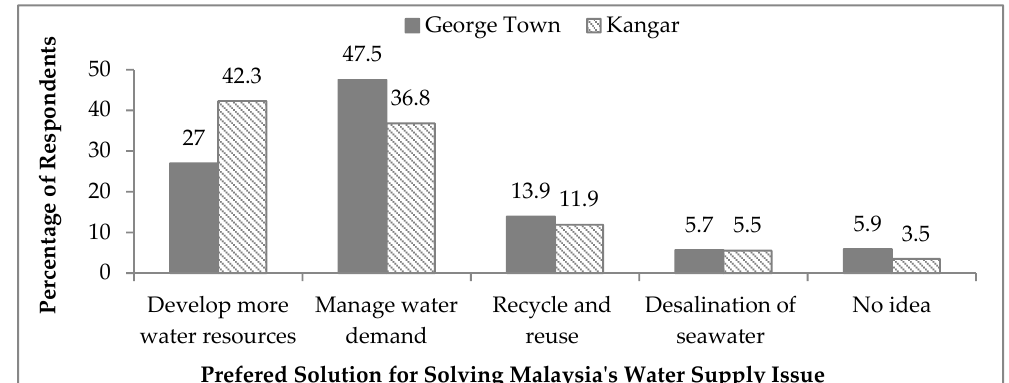
Figure 3. Public preference of the solution in solving Malaysia’s water supply issue.